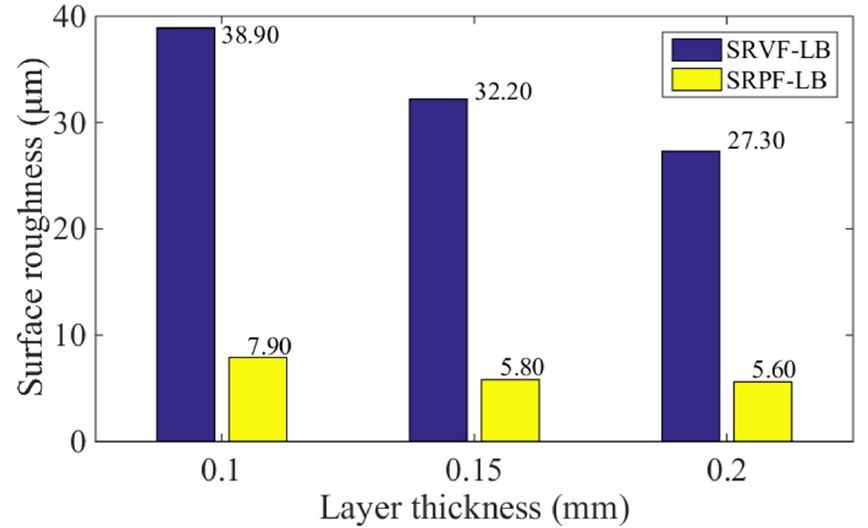
Figure 17. Effect of different layer thickness on the SRVF-LB and SRPF-LB.